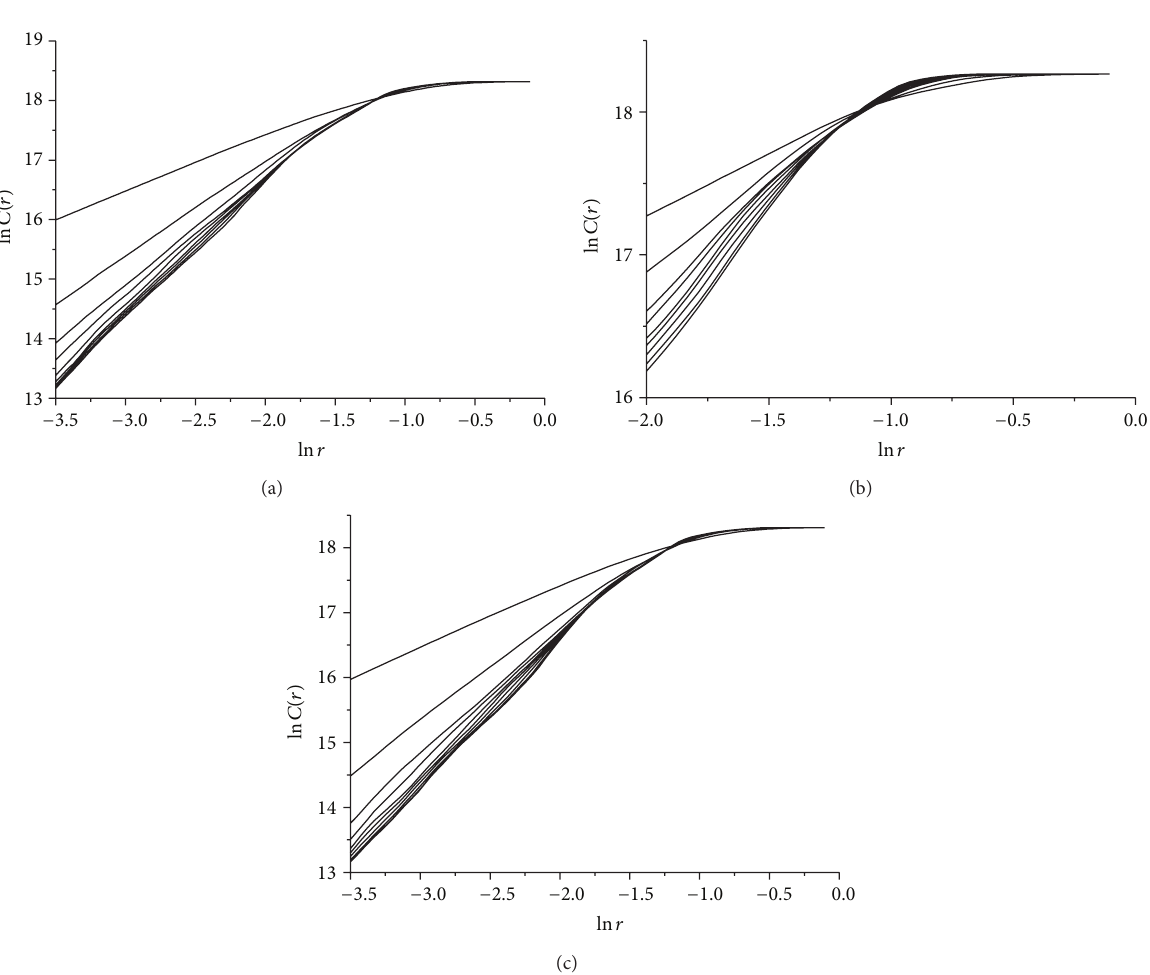
Figure 10: Relation between ln 𝐶(𝑟) and ln 𝑟 for different embedding dimensions 𝑚 for spin rate 𝜔 1 (𝑡) time-series, for (a) wax, (b) gypsum, and (c) lead